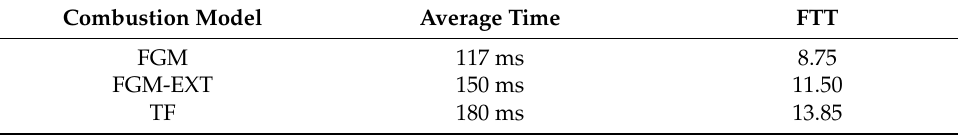
Table 2. Simulation average time with estimated FTT for each combustion model.